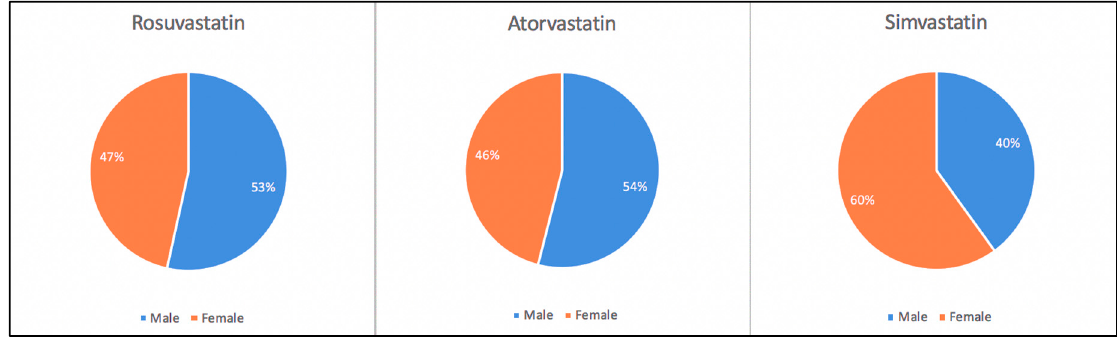
Figure 2. Prescription patterns of statins by gender.